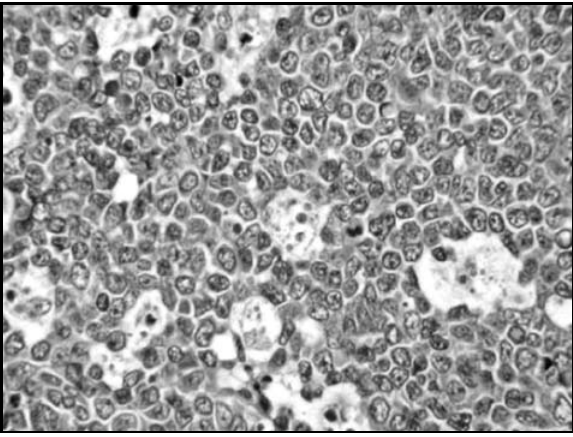
Figura 1 (caso 1) – População de células imaturas com macrófagos de permeio caracterizando o aspecto de céu estrelado (HE, 400x)